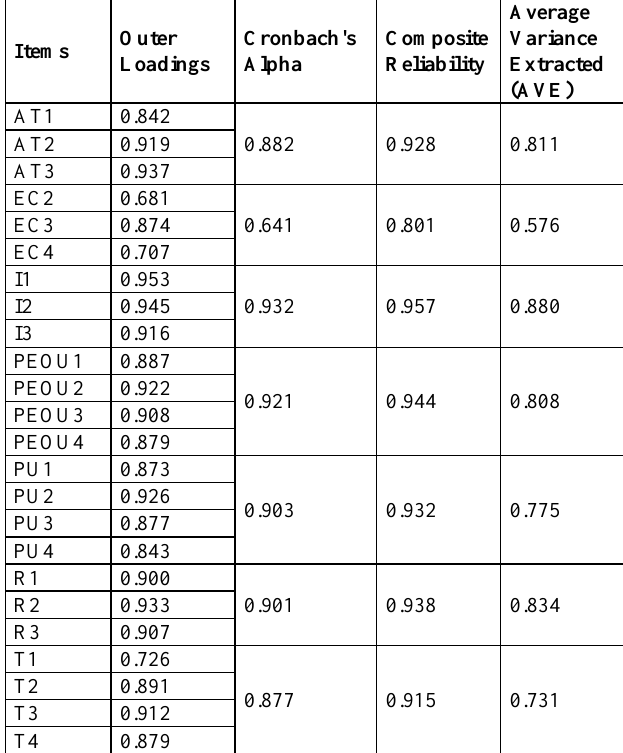
Table 1: Results of the Measurement